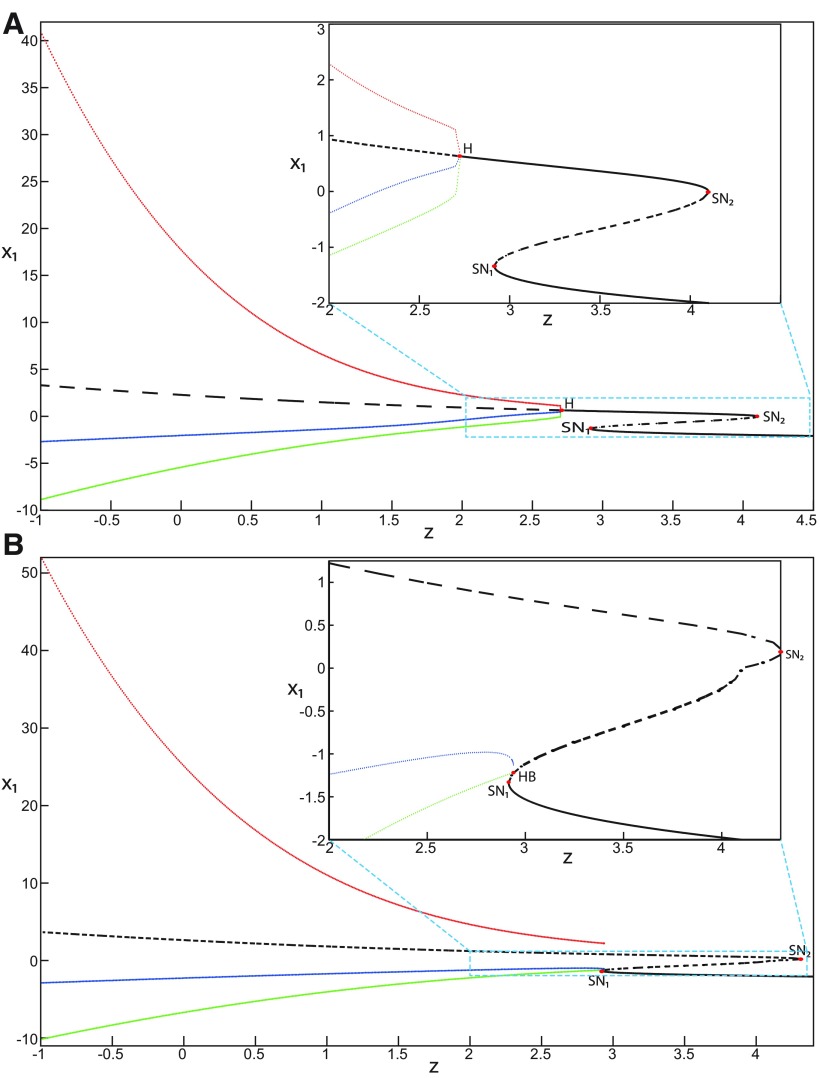

A, B, The (z,x1) subsystem 1 bifurcation diagram with respect to z (z<z(SN)), when m  =  0 (A) and m  =  2 (B). Z-lower (solid) and Z-middle (dash-dotted) branches consist of stable nodes and saddles, respectively. Z-upper branch consists of unstable foci (B), and it is divided into two sub-branches separated by a Hopf bifurcation, H (A): one (solid) consists of stable foci and another (dashed) consists of unstable foci. The Z-lower and Z-middle branches collide as z decreases in a saddle-node bifurcation SN1. The Z-upper (solid for A and dashed for B) and Z-middle branches collide as z increases in a saddle-node bifurcation SN2. A stable limit cycle ends at a Hopf bifurcation (A) and at a homoclinic bifurcation (B). The curves max(x1), min(x1) and <x1)> correspond to the maximum, minimum, and averaged values along periodic orbits.